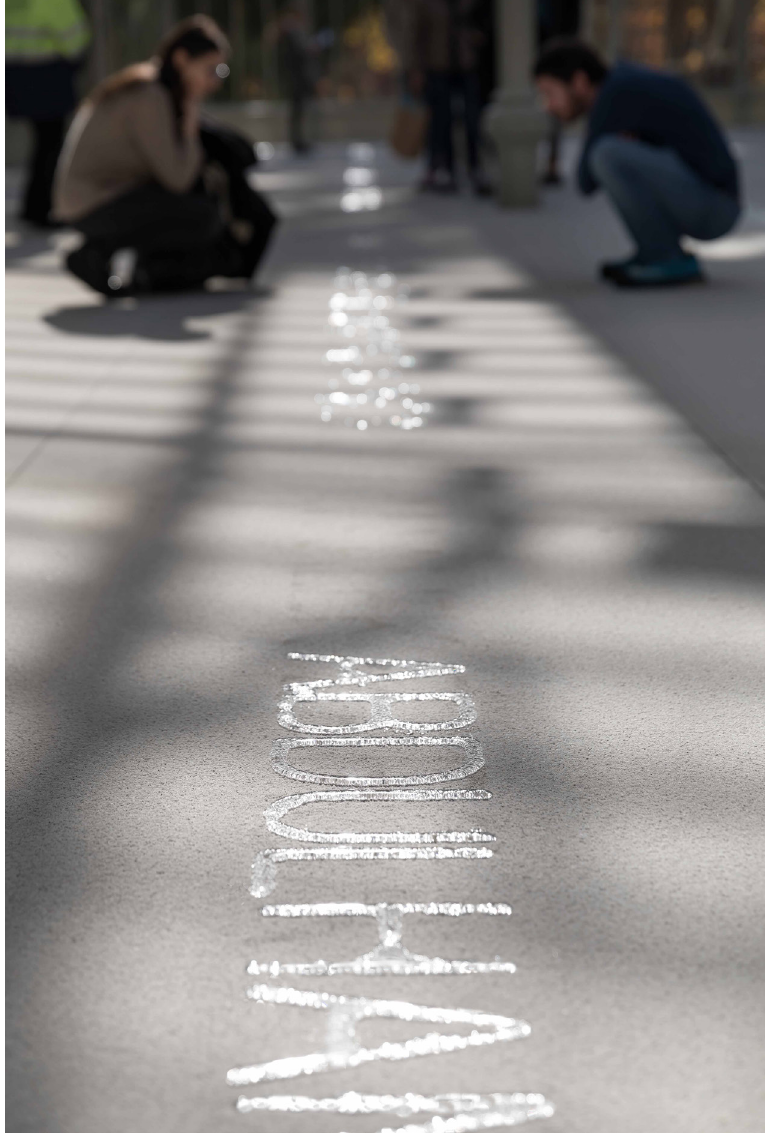
character . Both figure and character can be seen as figurations: figurative in that they embody ideas shaped in forms, and figures of anthropomorphic appearance that are, do, and appear. It is the convergence of figure and character in their guise of figurations that projects the terms in which we tend to analyse art. I see in the convergence between art and its analysis the work of “the anthropomorphic imagination.” With this newly-coined and somewhat clumsy term, I mean a tendency to approach cultural artifacts through the lens or frame of frequently unacknowledged anthropomorphic concepts. The tools of analysis are thus made congruent to the objects.